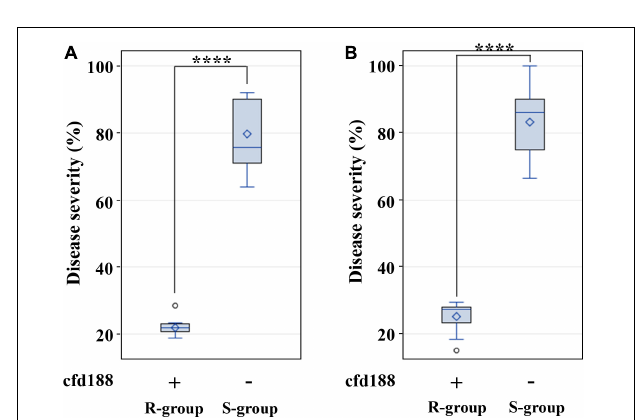
FIGURE 6 | Boxplots showing the effect of QLr.cau-6DL on leaf rust severities in the BC 3 F 2 : 3 family groups from Aikang58 (AK58) × BQM (A) and Jimai22 (JM22) × BQM (B) . R-group plants were positive for cfd188 (+), and S-group plants were negative for cfd188 (-). Tests were conducted under greenhouse conditions in 2018. **** indicates significant difference at p < 0.0001 based on Fisher’s least significant difference test. Refer to the caption of panel Figure 5 for descriptions of